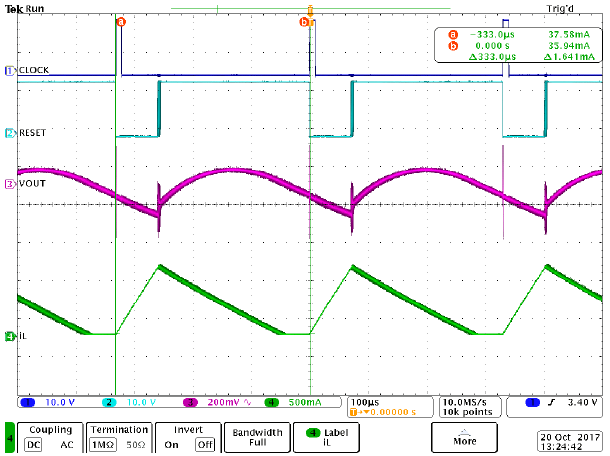
Figure 9. Schematic of the experimental boost DCM converter employing proportional voltage-mode control.